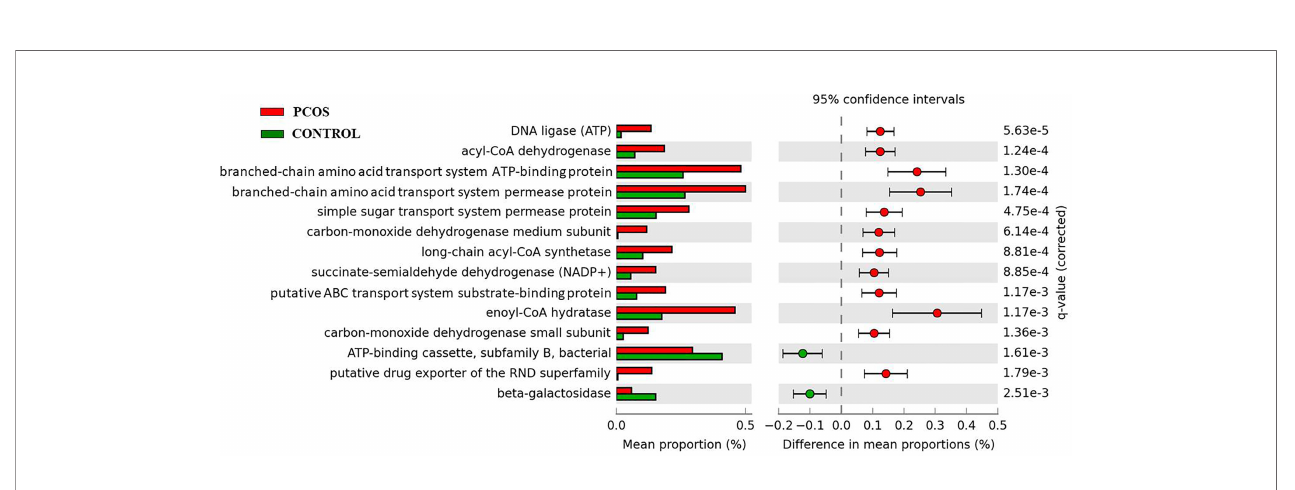
FIGURE 3 | Linear discriminant analysis effect size (LEfSe) analysis of the two groups. (A) Linear discriminant analysis (LDA) represented statistical and biological differences between the two groups (LDA > 3.0, p < 0.05). (B) Cladogram demonstrated microbiome differences of the two groups at various phylogenic